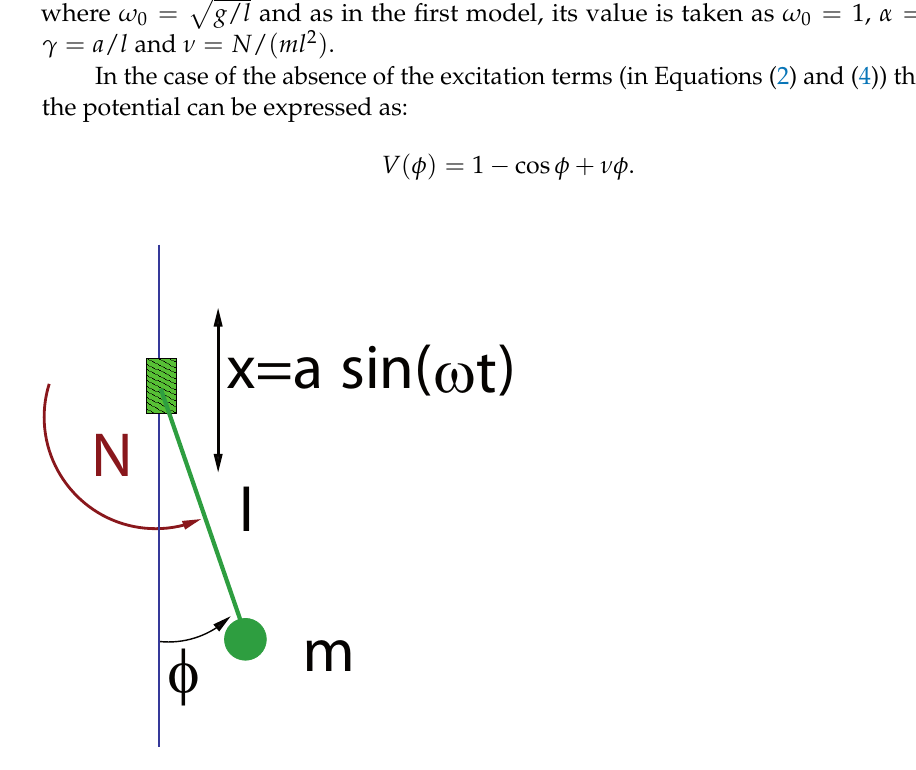
Figure 3. A schematic of the vertically excited parametric